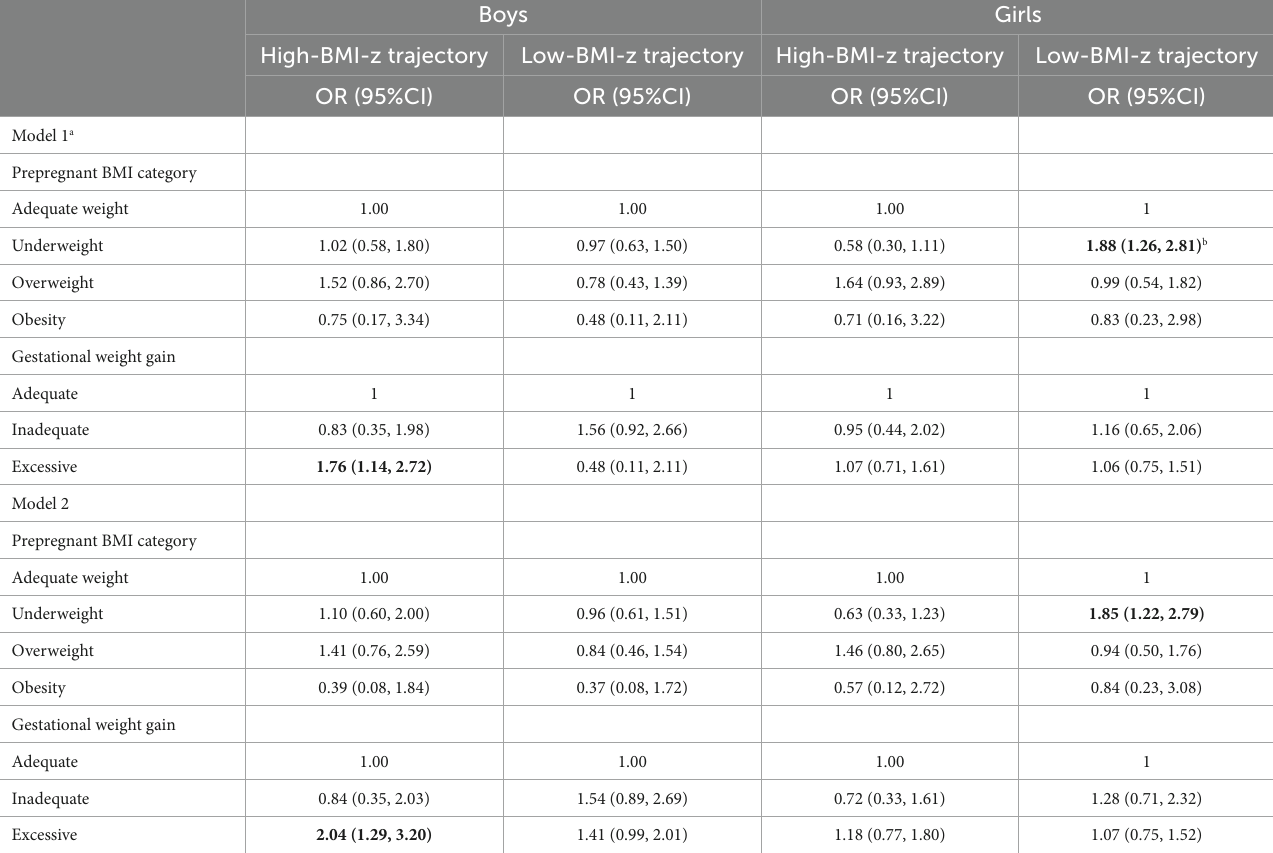
TABLE 3 The independent associations of prepregnant BMI and GWG on child BMI-z growth trajectory OR